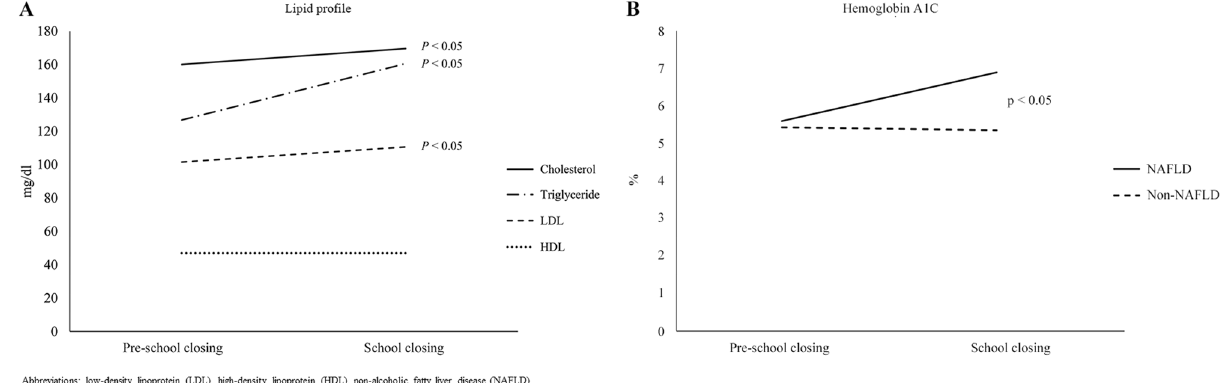
Figure 2. Comparison laboratory results between the pre-school closing and during school closing. ( A ) Lipid profile, ( B ) HbA1C between with and without NAFLD group.